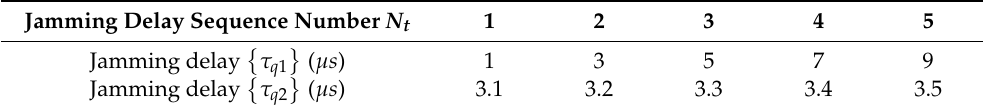
Table 1. Jamming delay sequence.